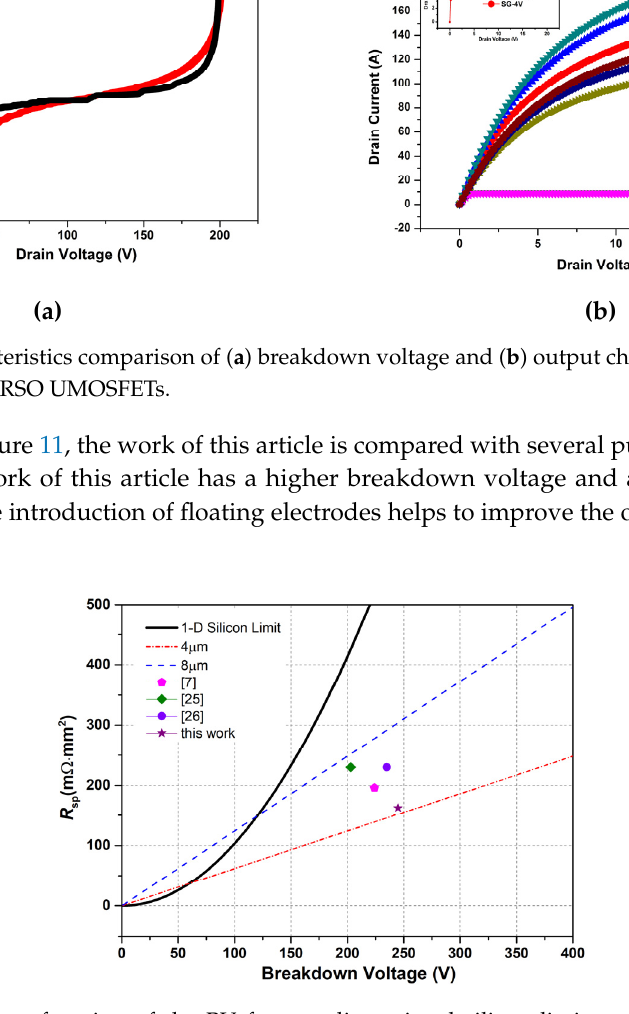
Figure 11. R SP as a function of the BV for one-dimensional silicon limit and two-dimensional charge-coupling limits for the pitches of 4 and 8 µ m, some references [7,25,26] and this work.